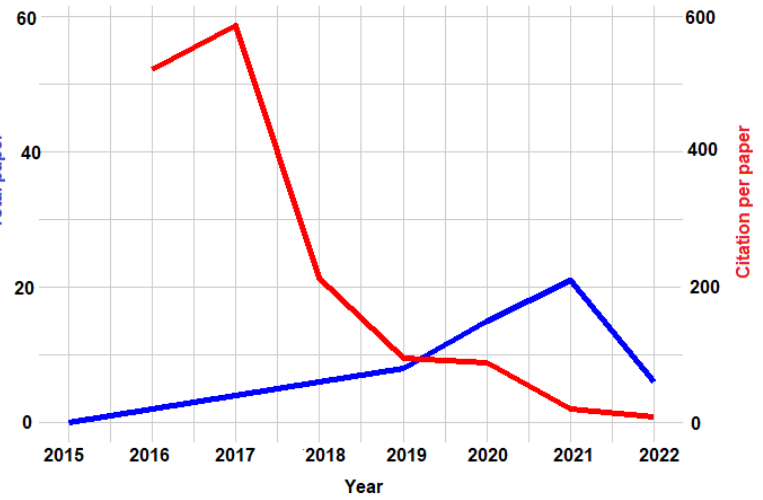
Figure 4. Citation trend from 2015 to 2022. Citation trend and paper production rate change over years shown with two